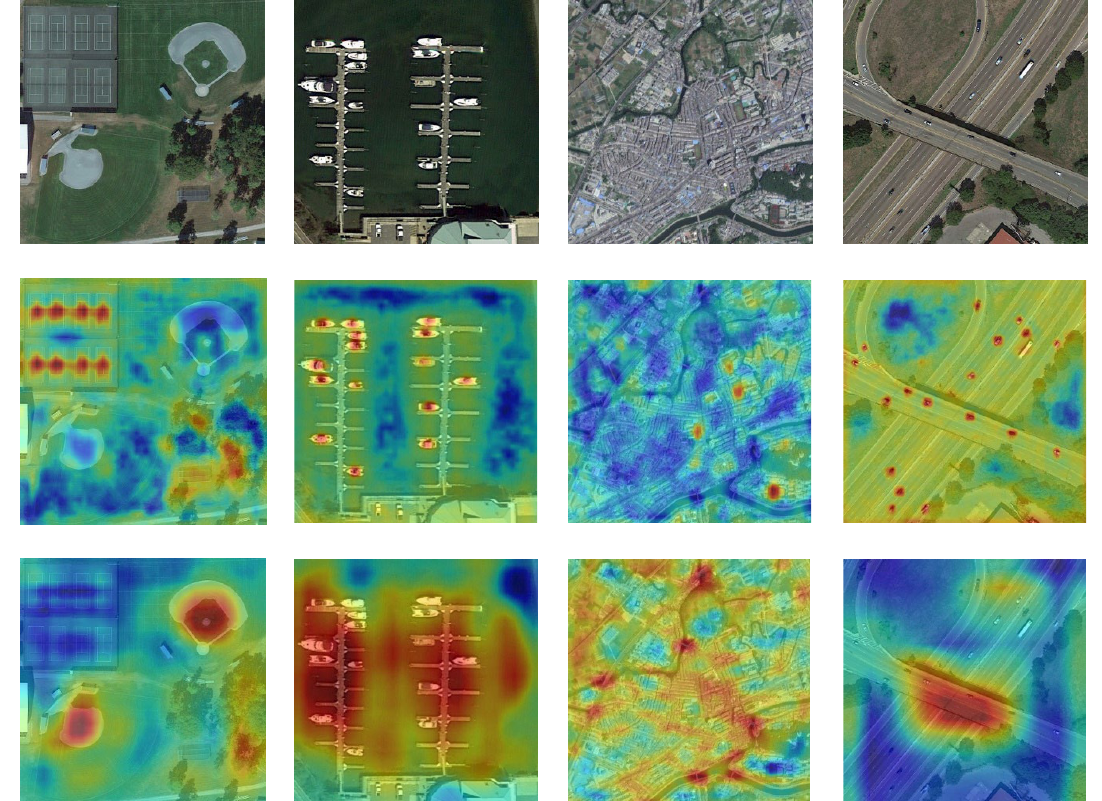
Figure 12. Visualization of objects with different scales in the same image.